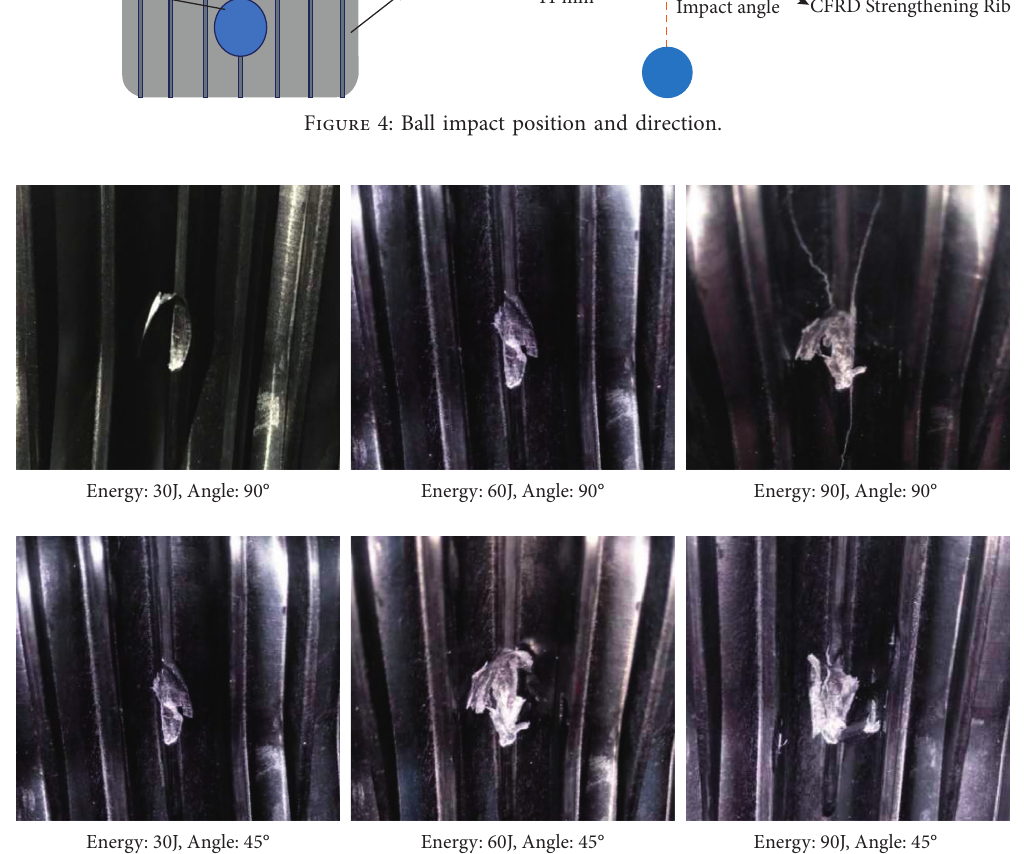
Figure 5: Photographs of the damage of oil sump after 131g ball